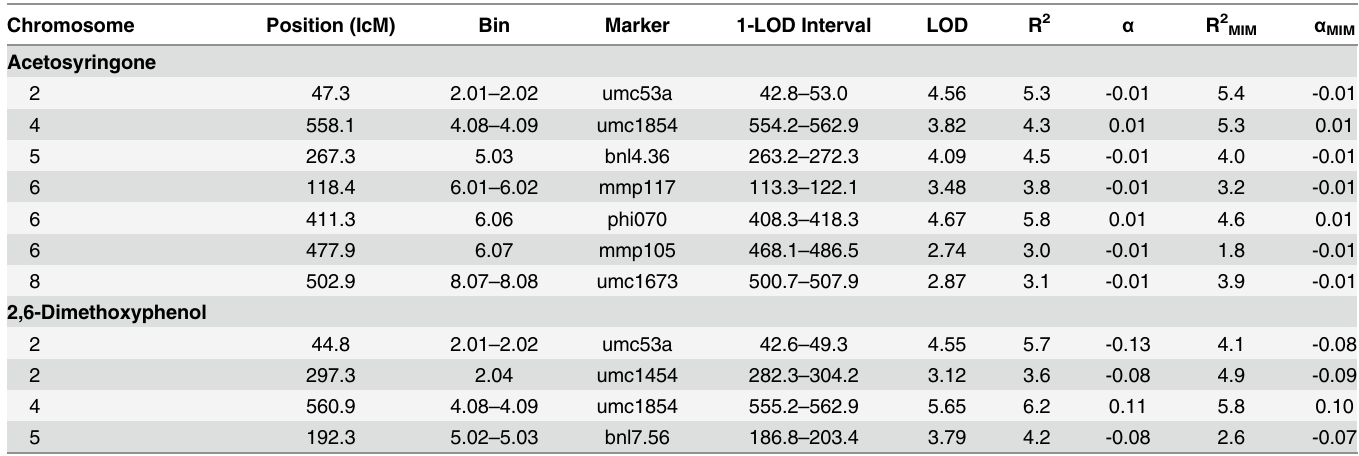
The number of QTL for each compound, chromosome number, chromosome position, bin, closest marker, Logarithm of the odds (LOD) score, 1-LOD support interval, phenotypic variance explained under the CIM model (R 2 ), additive effect for the B73 allele under the CIM model ( α ), phenotypic variance explained under the MIM model (R 2 MIM ), and additive effect for the B73 allele under the MIM model ( α MIM ) are shown. Data reported in Table 3 re fl ects values for lsmeans of combined